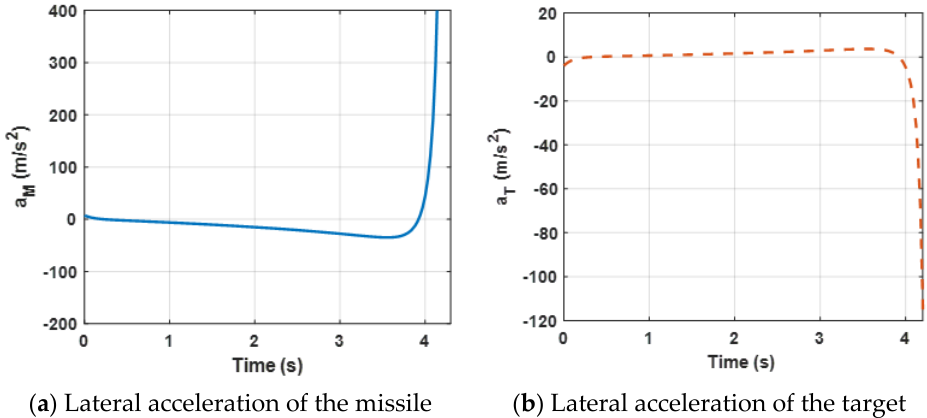
Figure 3. Curves of the angular rate and the relative velocity for the proposed guidance strategy.